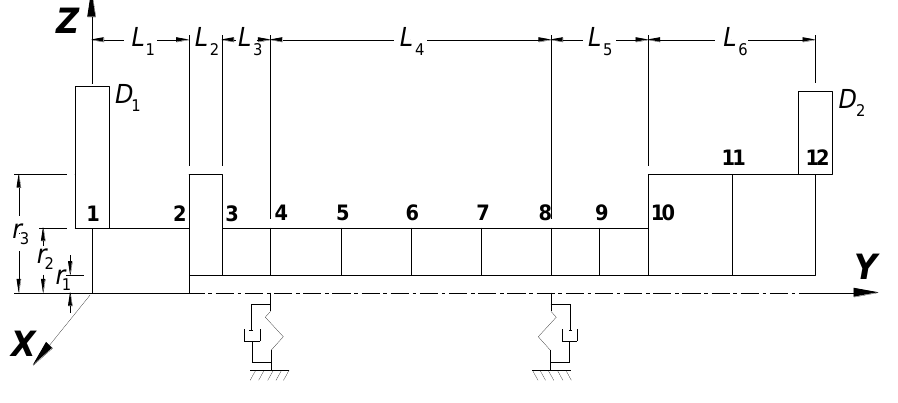
Figure 3. Rotor-bearing system scheme [40].